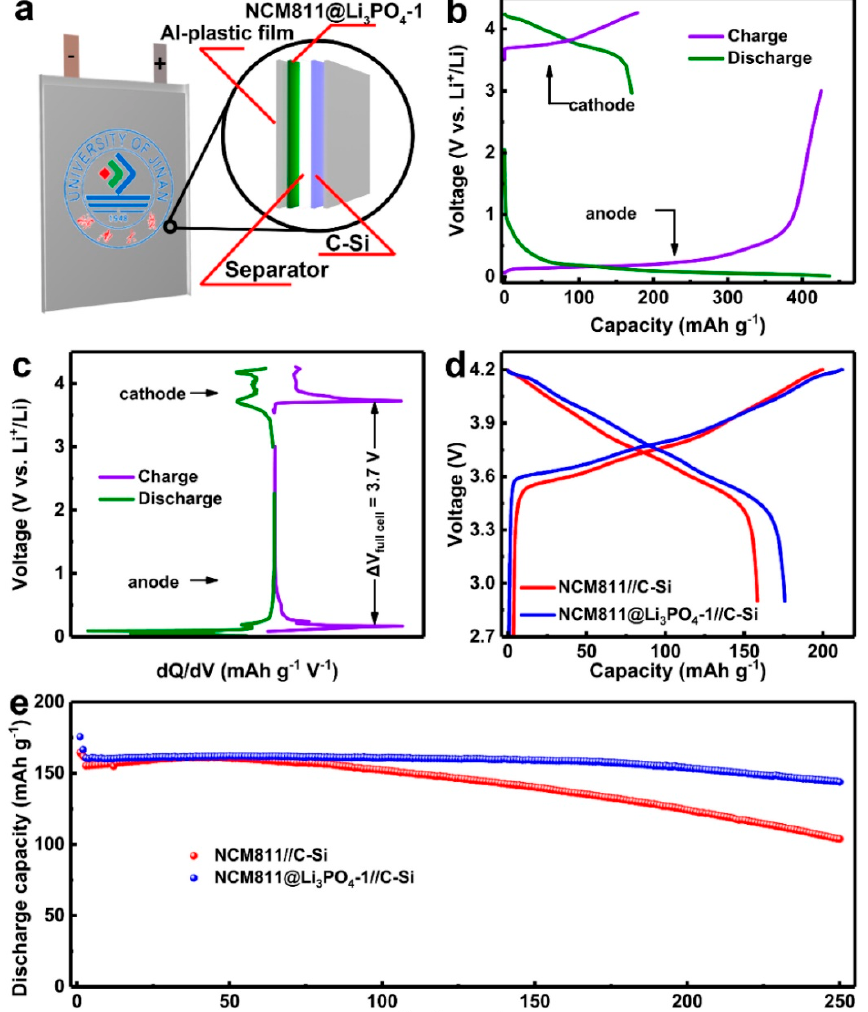
Figure 9. ( a ) Schematic illustration for the fabrication of the pouch ‐ type full Li ‐ ion cell with NCM811@Li 3 PO 4 cathode and C ‐ Si anode. Electrochemical properties of the full cell: ( b ) voltage ‐ capacity curves and ( c ) differential capacity curves. ( d ) The initial charge–discharge plots (0.1 C) and ( e ) long ‐ term cycling stability (1.0 C). Reproduced with permission from [180]. Copyright